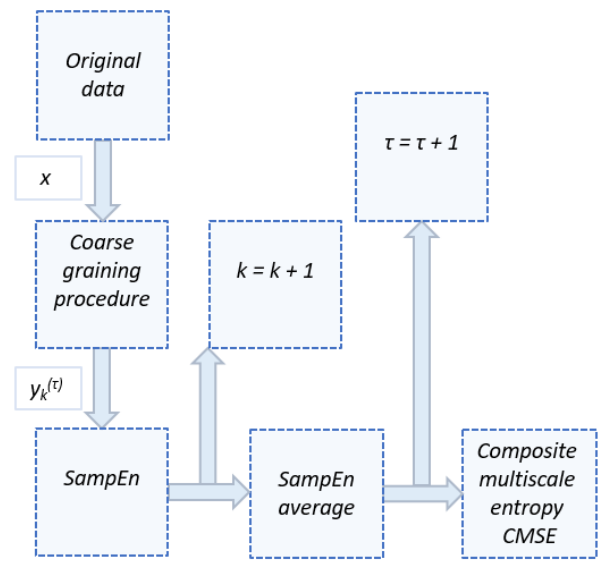
Figure 3. Composite multiscale entropy (CMSE) calculation algorithm.